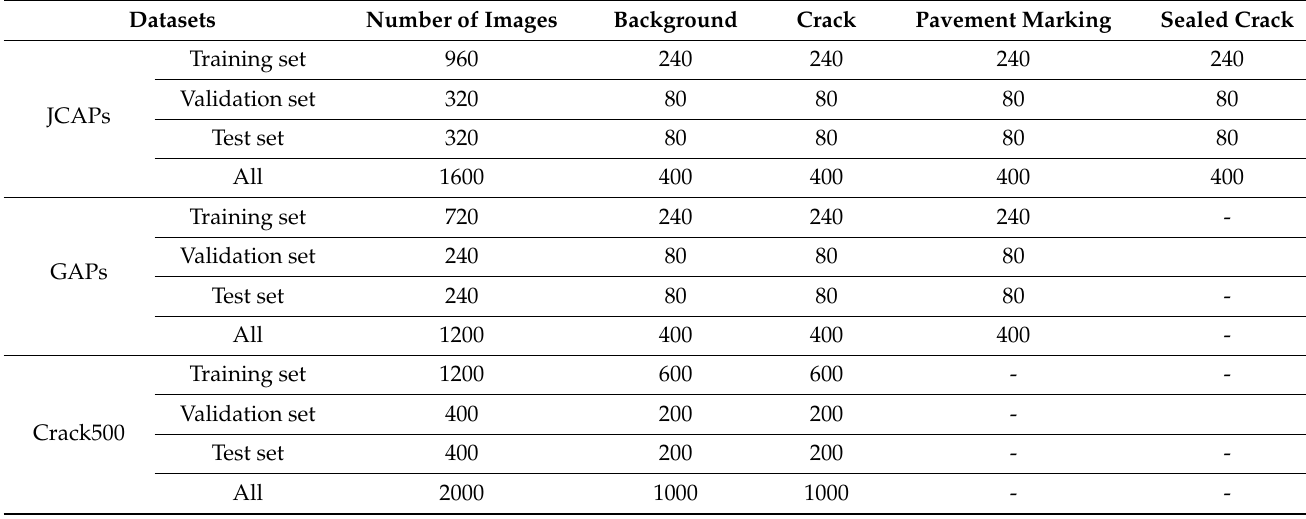
Figure 4. Example images from the Crack500 dataset used in this study: ( a ) background and ( b ) crack. In this study, 60% of every dataset was used as the training set for network training, 20% of every dataset was used as the validation set for network validation and monitoring, and 20% was allocated as the test set to evaluate different models. The different classes of samples in the dataset had a balanced distribution. Table 1 describes the distribution of pavement images in each classification in every dataset. Table 1. Distribution of different datasets used in this